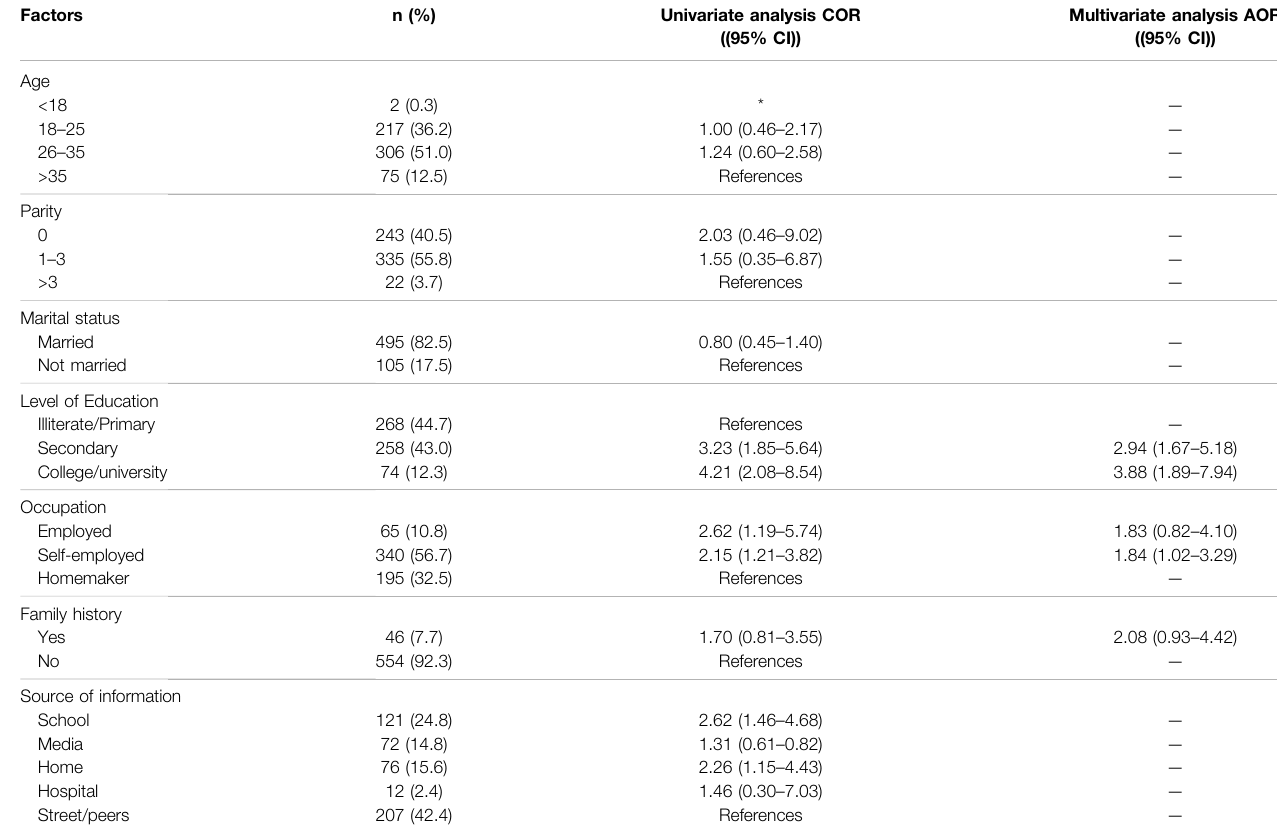
TABLE 5 | Regression analysis of factors in fl uencing knowledge of SCD among pregnant women attending ANC in Dar-es-Salaam. Factors n (%) Univariate analysis COR